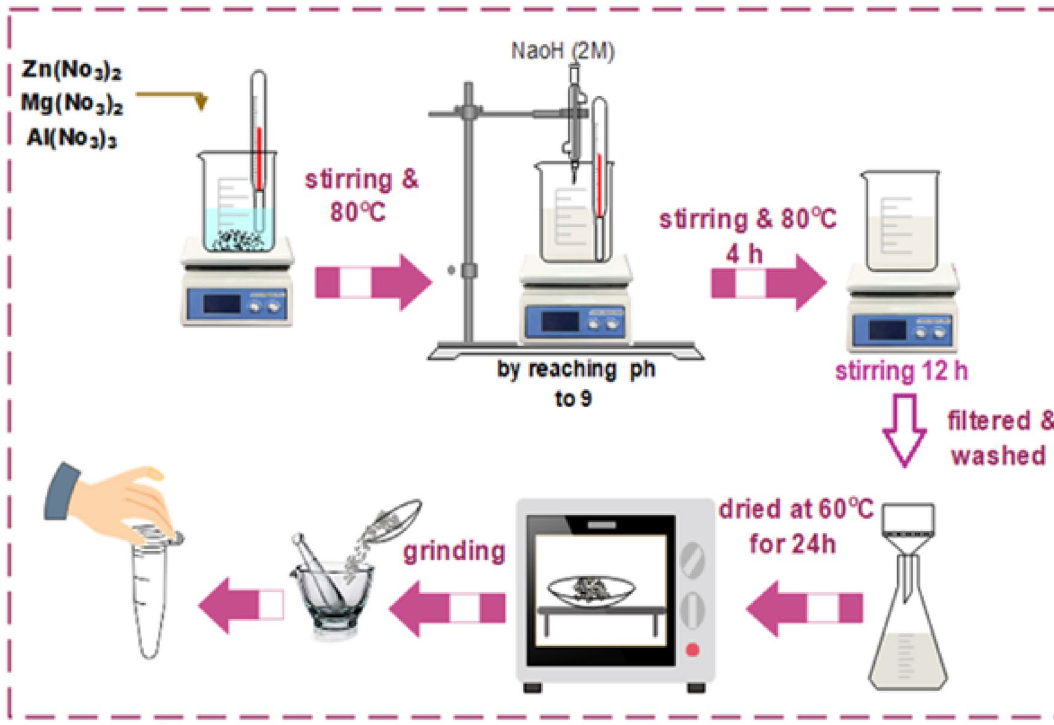
Figure 1. Preparation of